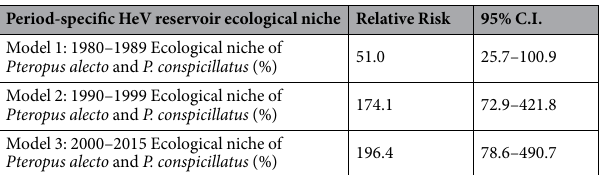
Period-specific HeV reservoir ecological niche Relative Risk 95% C.I.